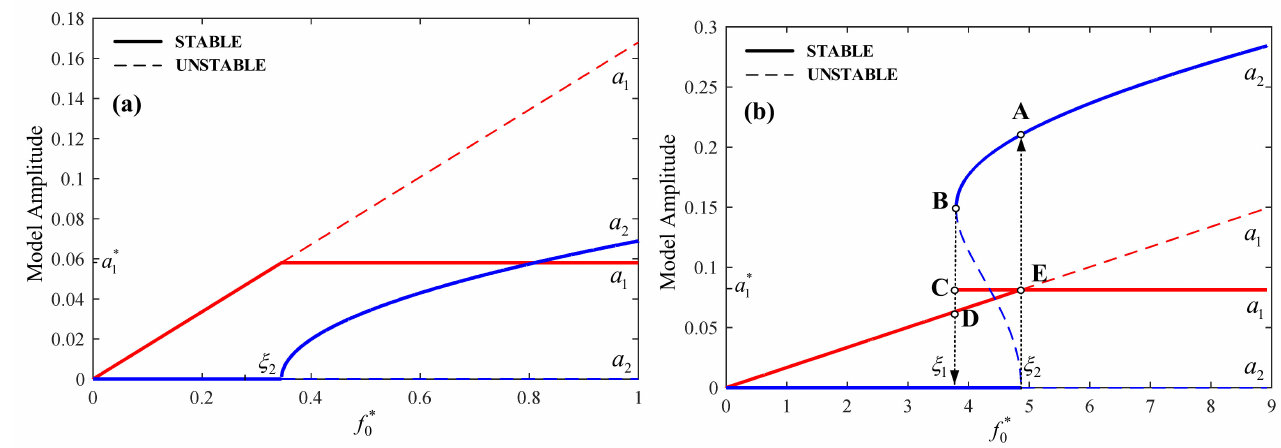
Figure 4. Effect of external excitation f ∗ ( b ) condition: ε = 0.05, σ 1 = 0, and σ 2 =